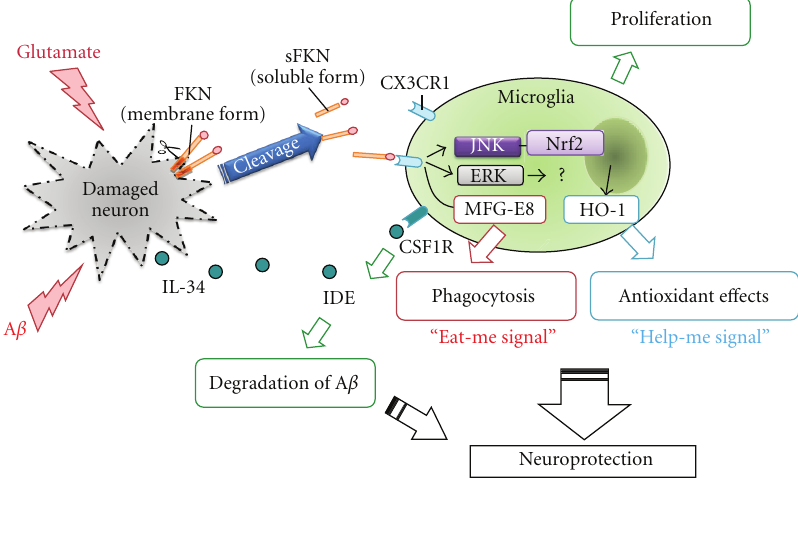
Figure 2: Model of the role of neuronal chemokine (FKN) and neuronal cytokine (IL-34) in microglial phagocytosis and neuroprotection. Neuronal cells primary produce chemokine fractalkine (CX3CL1; FKN) and cytokine IL-34. Microglia predominantly express its receptor, CX3CR1, and colony-stimulating factor 1 receptor (CSF1R). Soluble form of FKN (sFKN) is secreted from damaged neurons and promotes microglial phagocytosis of neuronal debris through the release of MFG-E8. sFKN also induces the expression of the antioxidant enzyme HO-1 in microglia via Nrf2 recruitment and activation of the JNK MAPK signaling pathway. The neuroprotective e ff ects of sFKN are also mediated in part by activation of ERK MAPK, although the downstream signaling pathway has not yet been elucidated. IL-34 promoted microglial proliferation and clearance of A β which mediates insulin-degrading enzyme (IDE) expression. Therefore, sFKN and IL-34 may be an intrinsic neuroprotectant for damaged yet surviving